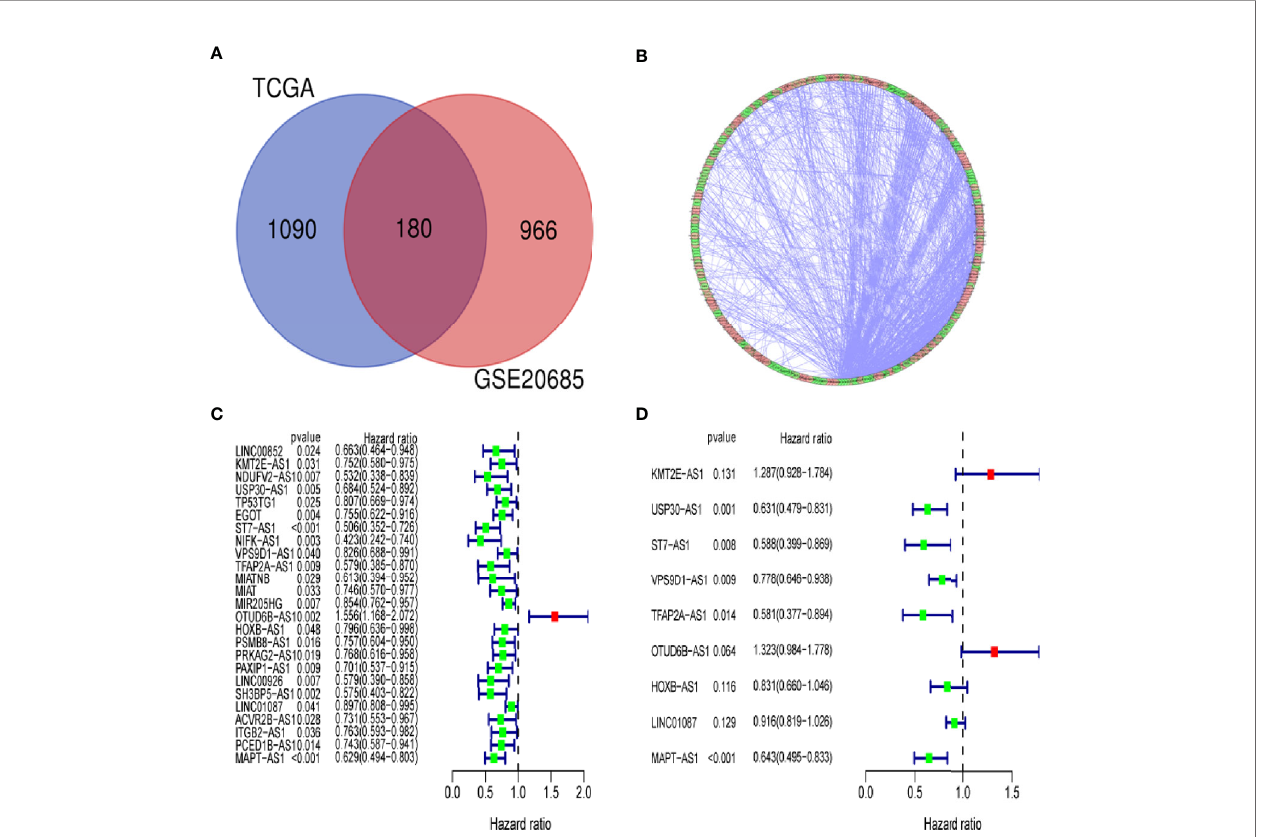
FIGURE 2 | Identi fi cation of an autophagy-related lncRNA signature in breast cancer. (A) Venn diagram describes 180 shared lncRNAs from 1,270 autophagy- related lncRNAs and 1,146 lncRNAs of GSE20685. (B) The network of autophagy-genes and lncRNAs. The blue nodes indicate autophagy genes and the pink nodes indicate lncRNA. The co-expression network is performed by CYTOSCAPE 3.7.2. (C) Univariate Cox regression analysis was used to con fi rm the lncRNAs associated with autophagy were strongly with patients ’ OS in training dataset. (D) Multivariate Cox regression analysis to construct the prognostic